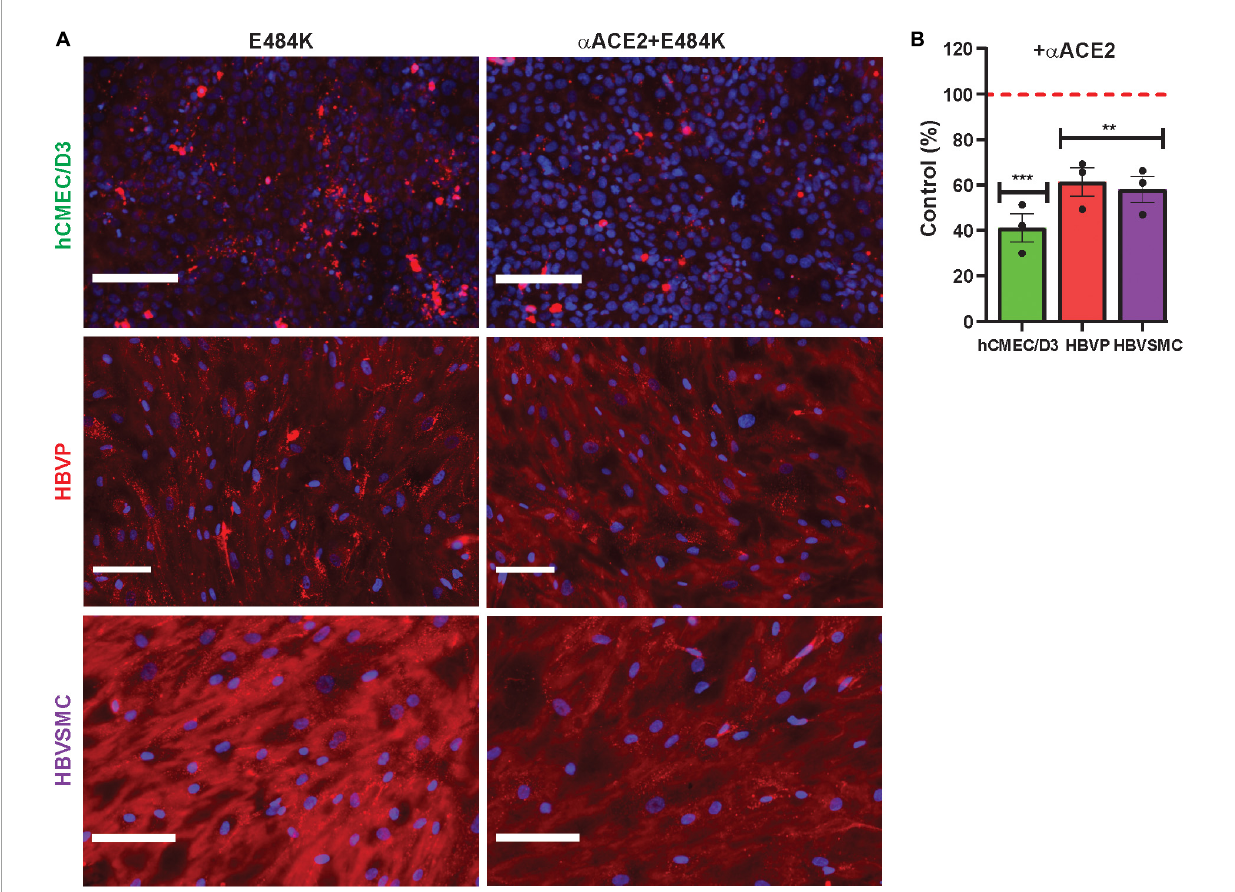
FIGURE6 Anti-ACE2 suppressed mutant SARS-CoV-2/SP E484K uptake by cerebrovascular cells. (A,B) Excess unlabeled α ACE2 suppressed labeled SP-555 E484K uptake in the hCMEC/D3 cells, HBVP, and HBVSMC compared to controls in the absence of unlabeled α ACE2 for each cell type. Red dashed line is control levels in the absence of α ACE2 (100%). Values are mean ± SEM. N = number of data points (wells) shown with the histogram. Scale bar = 100 µ m. Supplementary Figure 7 . ** P < 0.01; *** P <